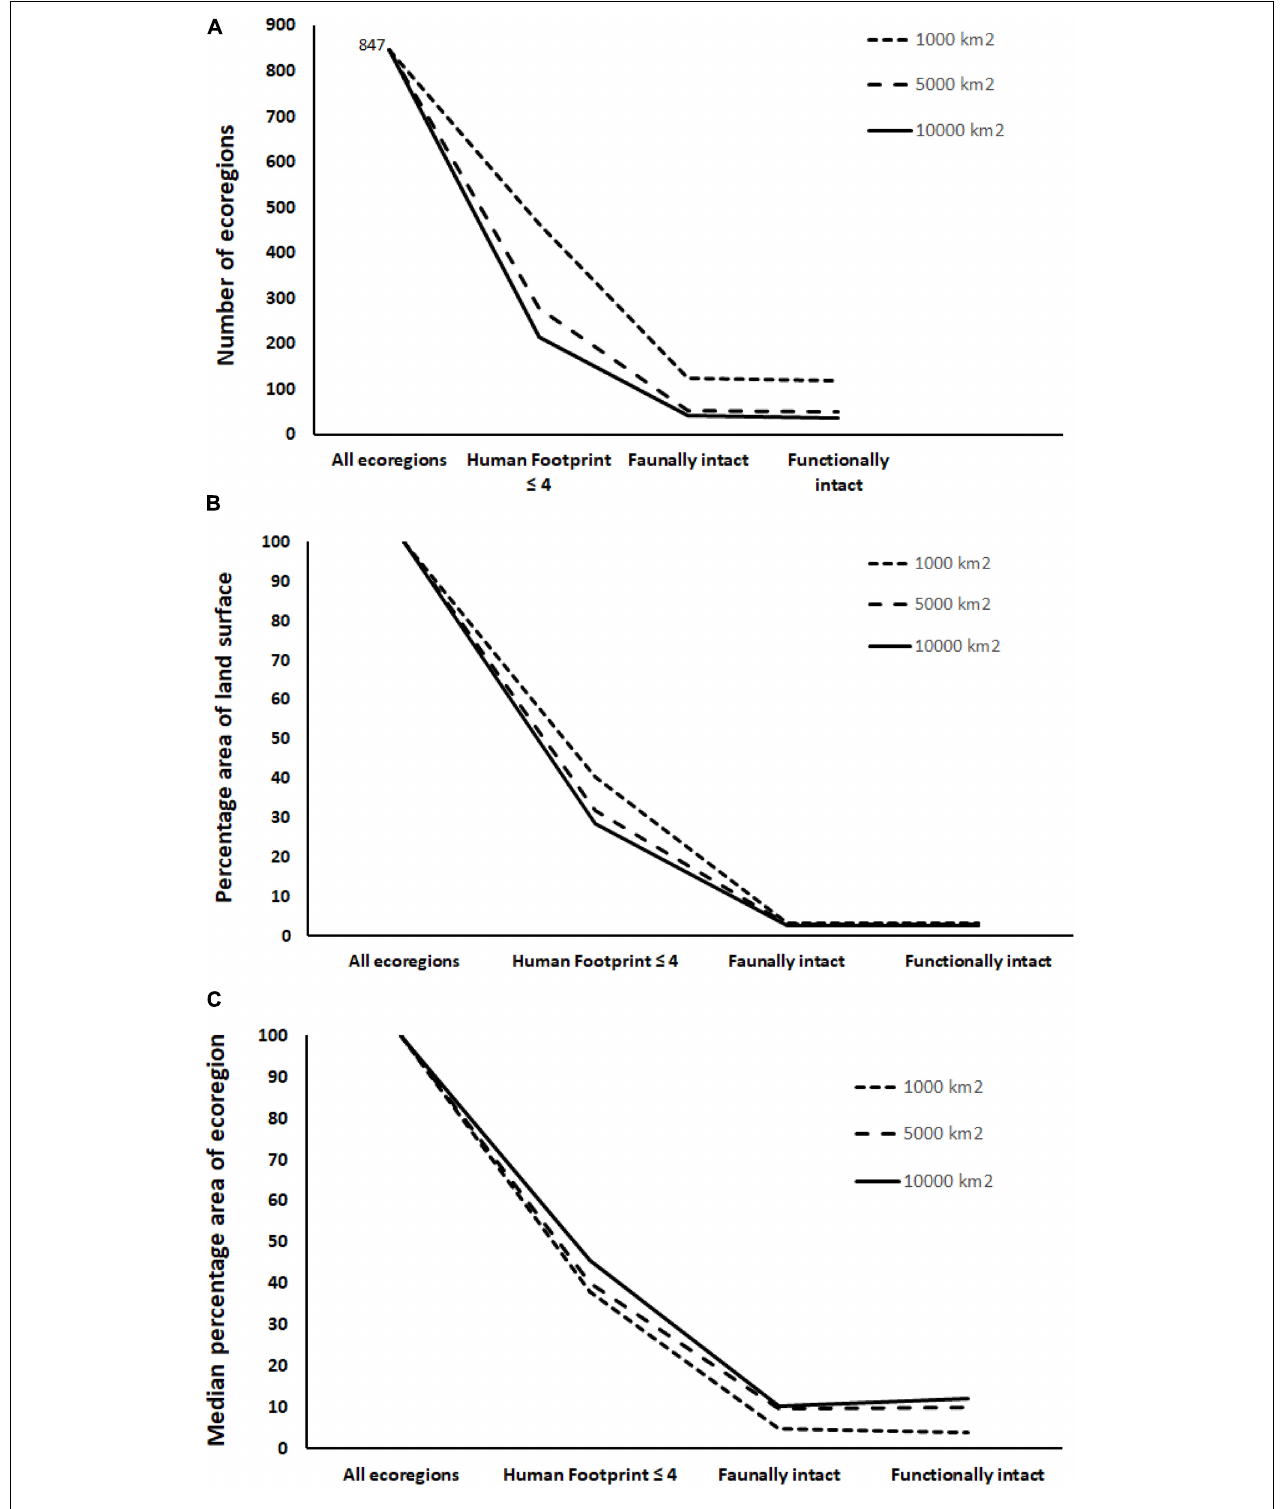
FIGURE 3 | Changes in (A) number of ecoregions, (B) percentage area of terrestrial surface and (C) median percentage area of each ecoregion remaining as first HF ≤ 4, then faunally intact and finally functionally intact areas are selected, showing the cumulative loss with each layer. Results are shown for minimum areas of 1,000, 5,000, and 10,000 km 2